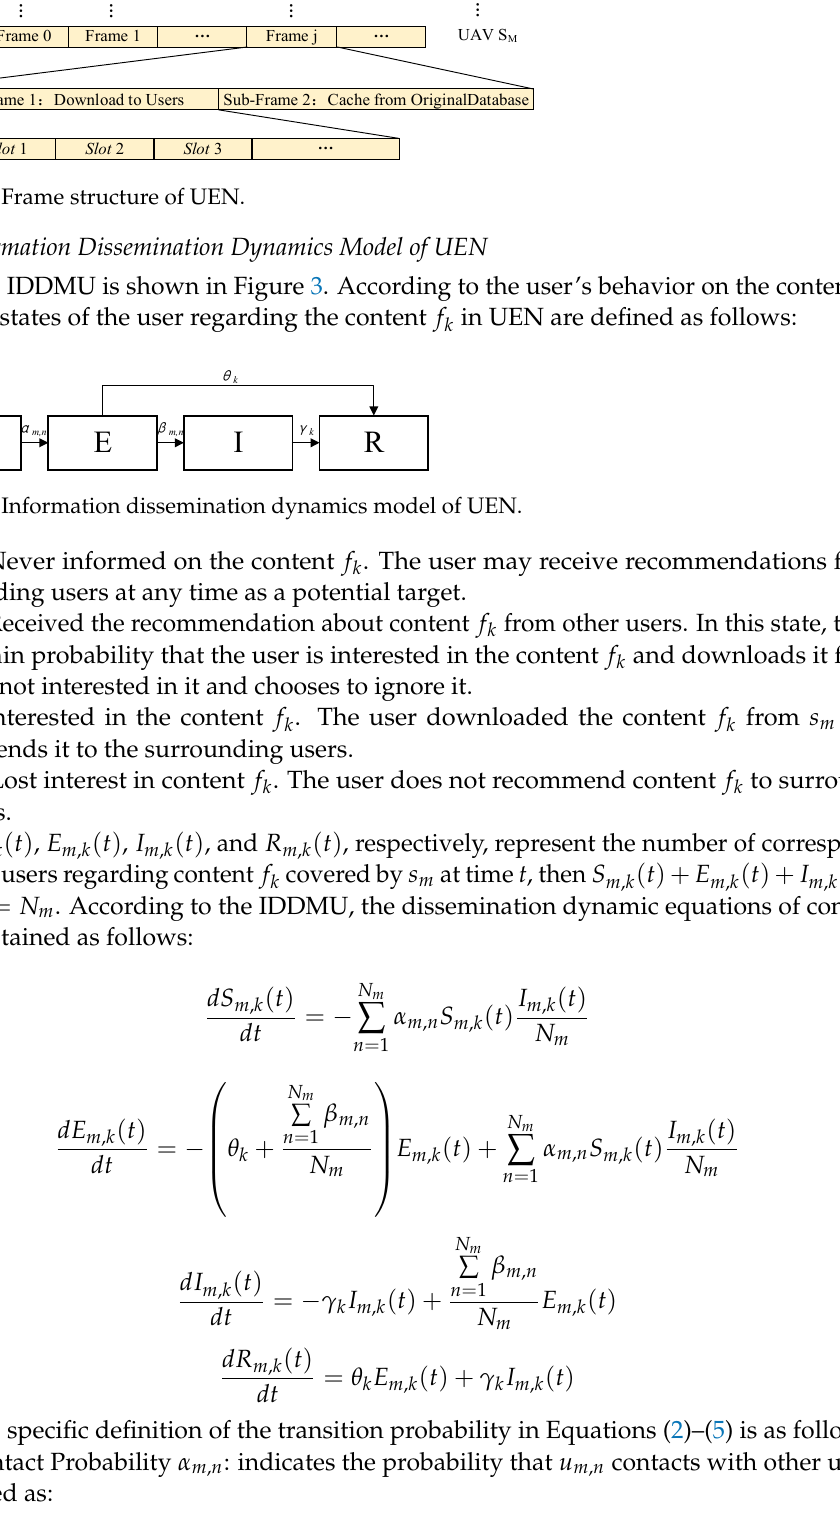
Figure 2. Frame structure of UEN.